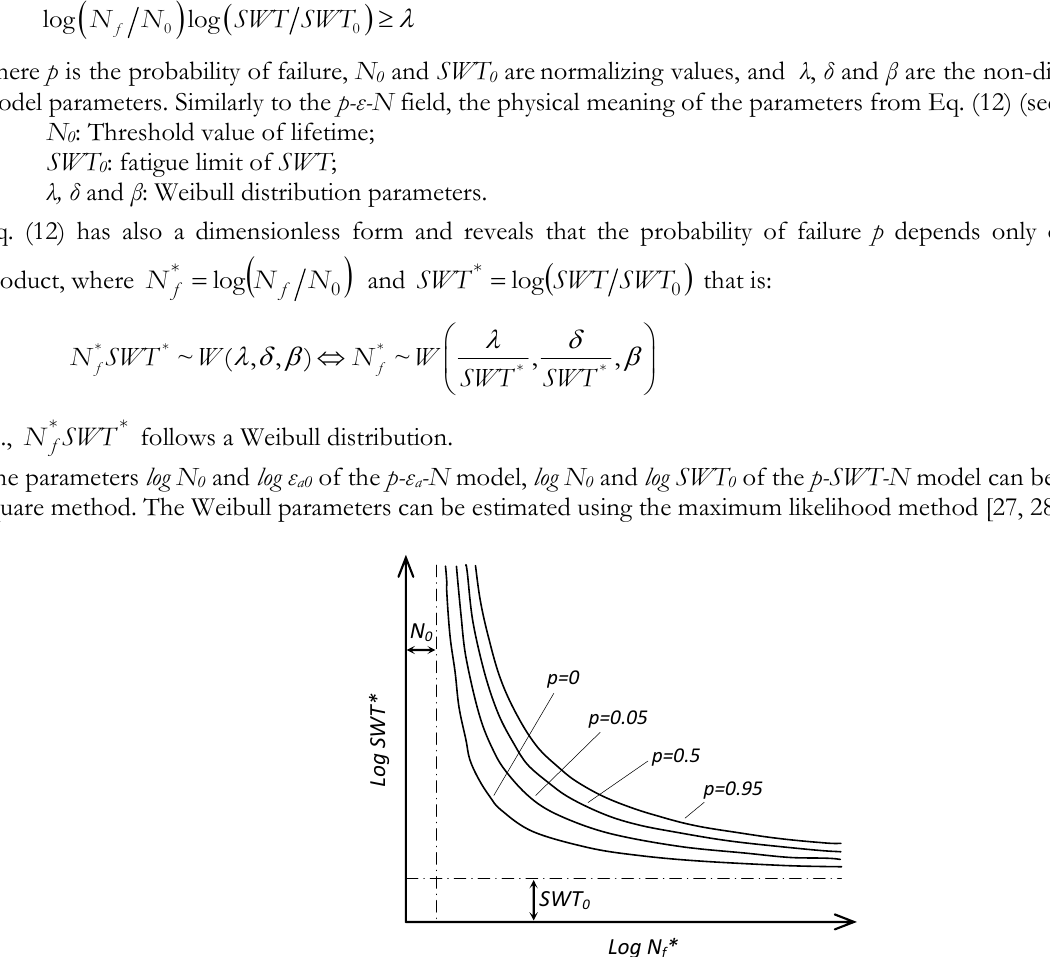
* , and the SWT* damage parameter: p - f